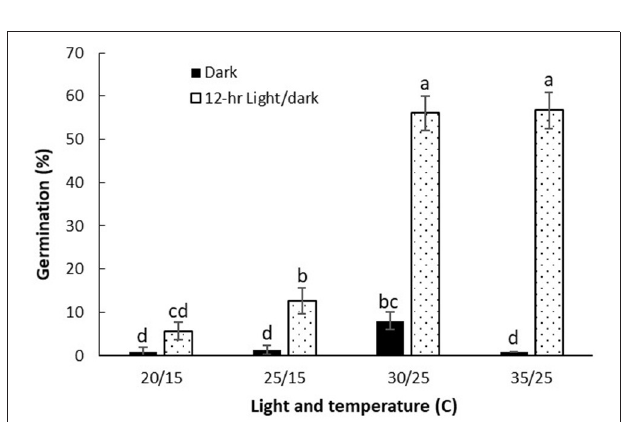
FIGURE 2 | Impact of light on the germination of P. capillare . Vertical bars represent the standard error of the mean.